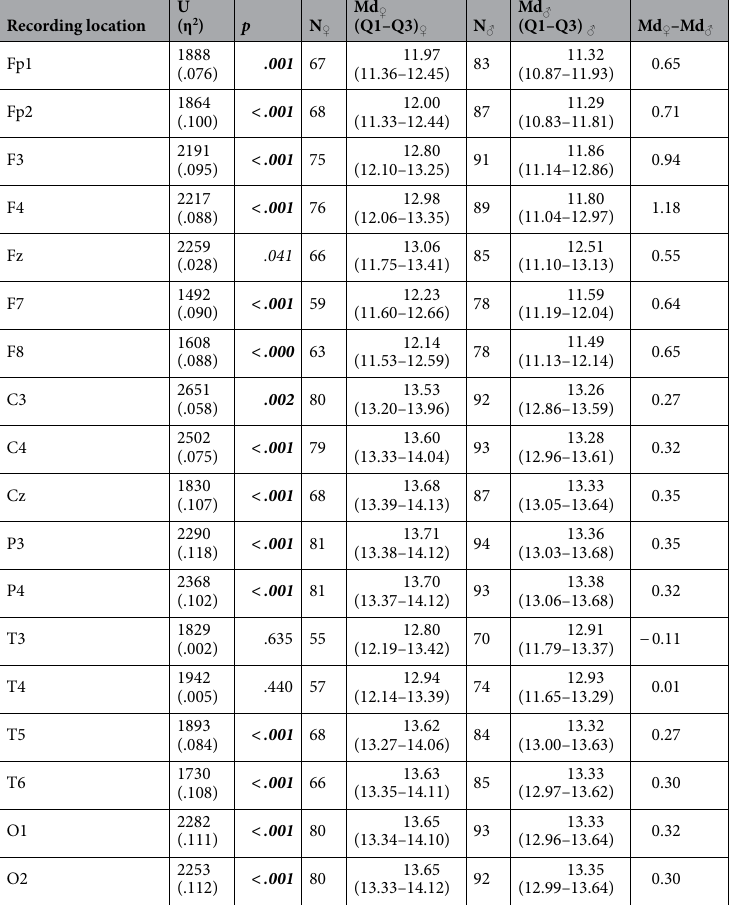
Table 1. Women vs men differences in NREM sleep EEG spindle spectral peak frequencies. Mann–Whitney U test indicates that women as compared to men are characterized by higher f maxPeak values at which spindle range P Peak (f) maxima emerge. The Rüger area containes 16 nominally significant effects. 15 of these women vs men differences were significant at both of the more stringent criteria ( p < .025 and p < .017), which supports the significance of the area. Italic and bold italic values indicate statistical significance at p < .05 , and p < .017, respectively. Md